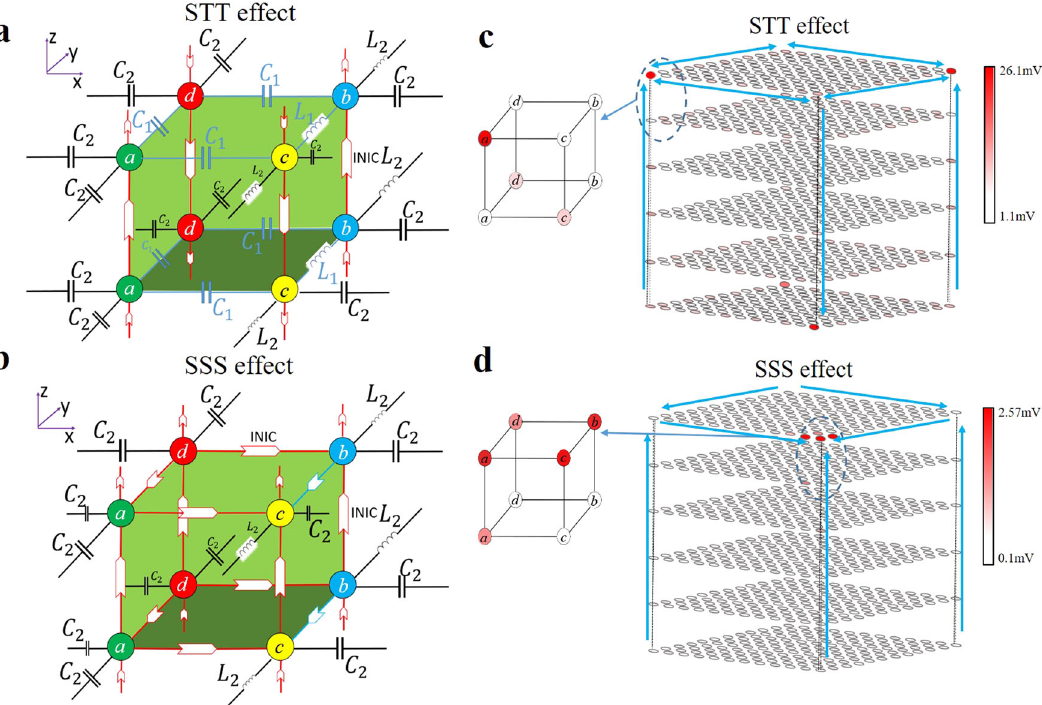
Fig. 5 The circuit design and results for the hybrid 3D skin-topological-topological (STT) effect and 3D skin-skin-skin (SSS) corner effect. a, b The schematic diagrams for the unit cell of the total circuit with C 1 = 1 nF, L 1 = 3.3 uH, C 2 = 2.2 nF and L 2 = 1.5 uH. Arrows with different colors are the same as INICs labeled in Fig. 1d. Each unit cell contains four sublattices ( a , b , c , d ). a is for hybrid 3D STT effect and b is for 3D SSS effect. The details of INICs are in Fig.1d. c , d The voltage distributions at the resonance frequency for hybrid 3D STT effect and 3D SSS effect in ( c ) and ( d ), respectively. Big arrows in ( c ) show the directions of skin and topological pumping. Big arrows in ( d ) show the directions of skin pumping.